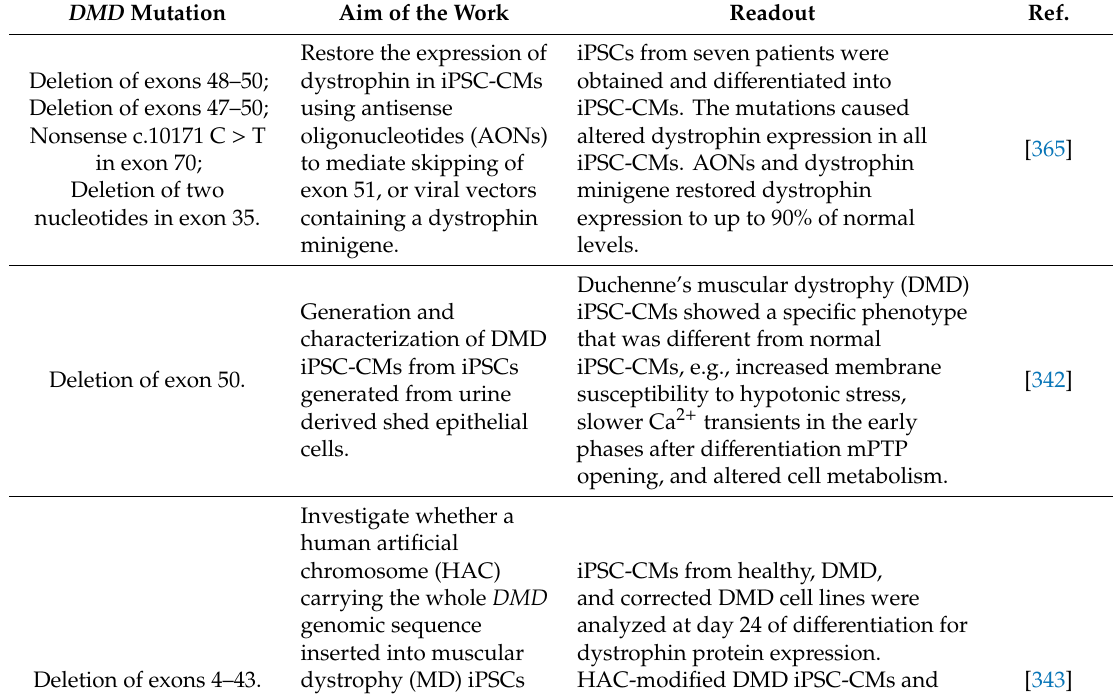
Table 1. Principal studies using cardiomyocytes derived from induced pluripotent stem cells (iPSC-CMs) to model and study dystrophin-associated cardiomyopathy